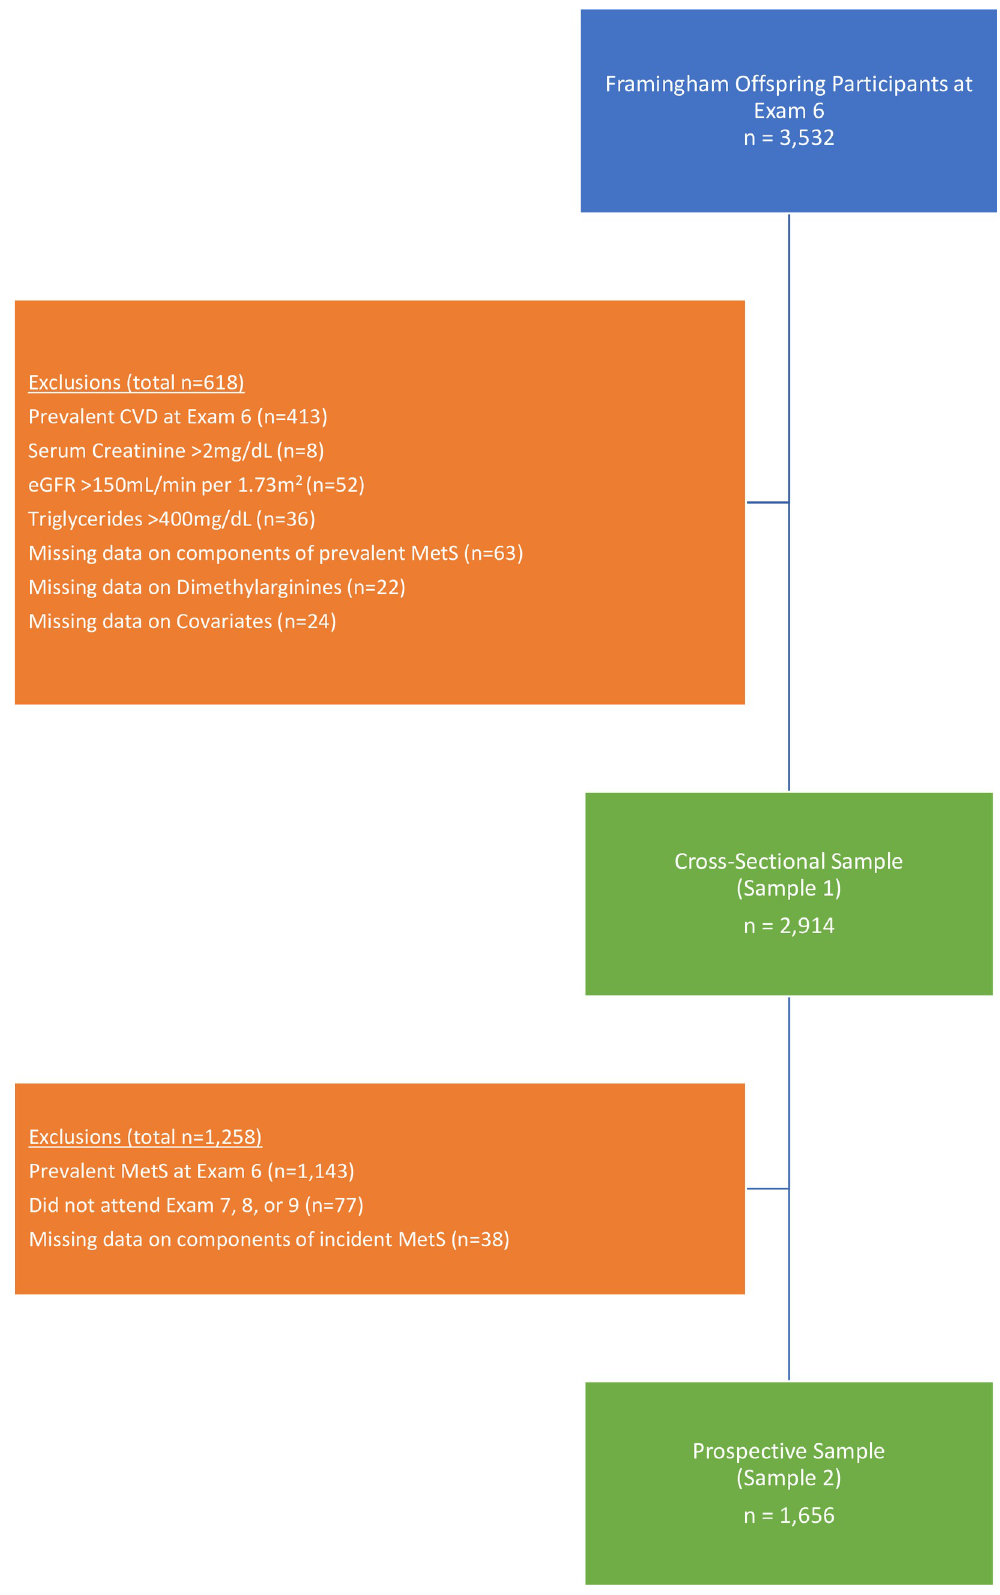
Fig 1. Sample exclusion